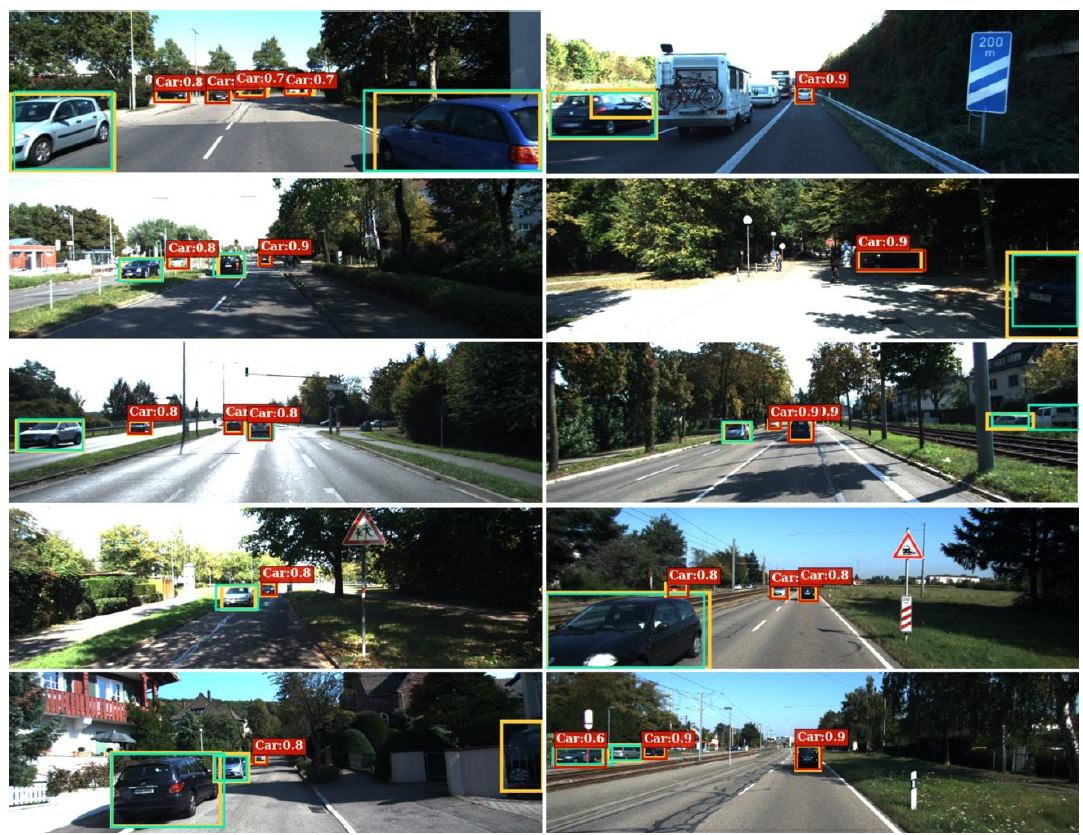
Figure 9. Qualitative examples from the test dataset. The FN predictions made by the proposed framework are denoted as red bounding boxes with car labels and the corresponding confidences. It can be seen that among all the ground truth car labels (yellow), the given object detector makes good detections (cyan) on the distinctive ones, while the proposed framework manages to predict the FN objects (red) missed by the detector even under perceptually degraded conditions.